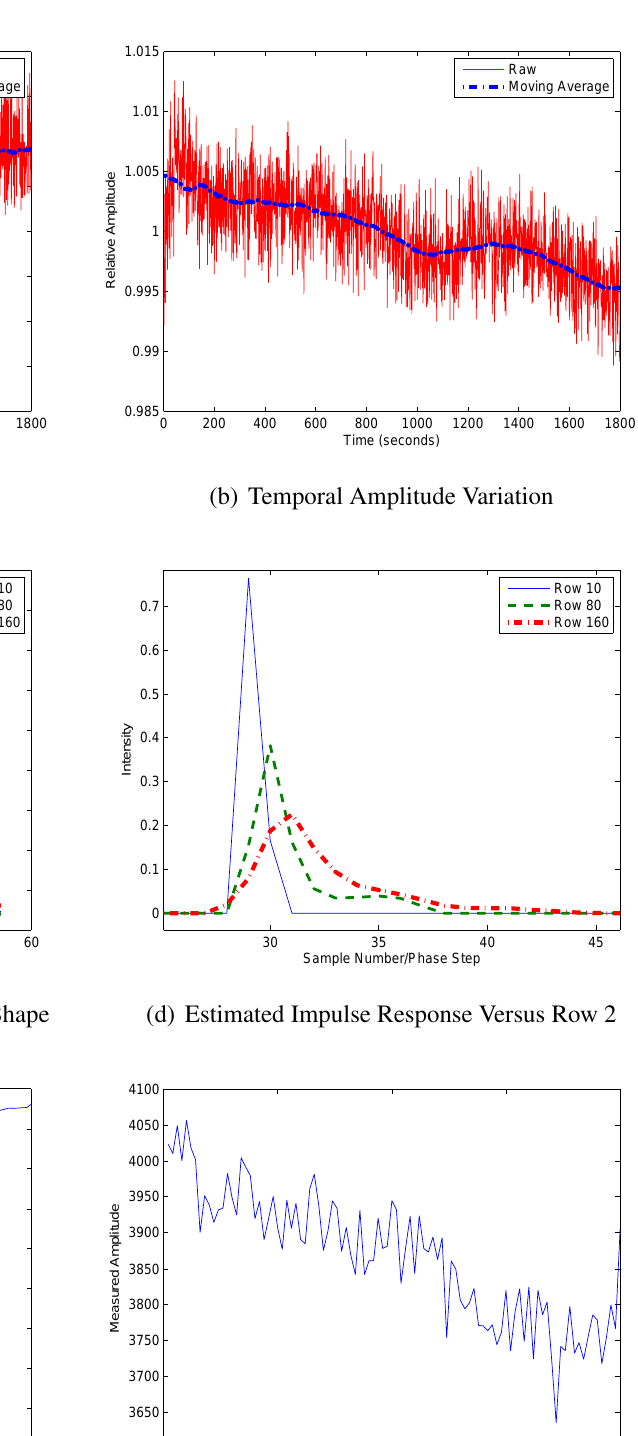
Figure 2. Spatial and long-period temporal variation in the reference waveform shape for a modulated CMOS sensor.